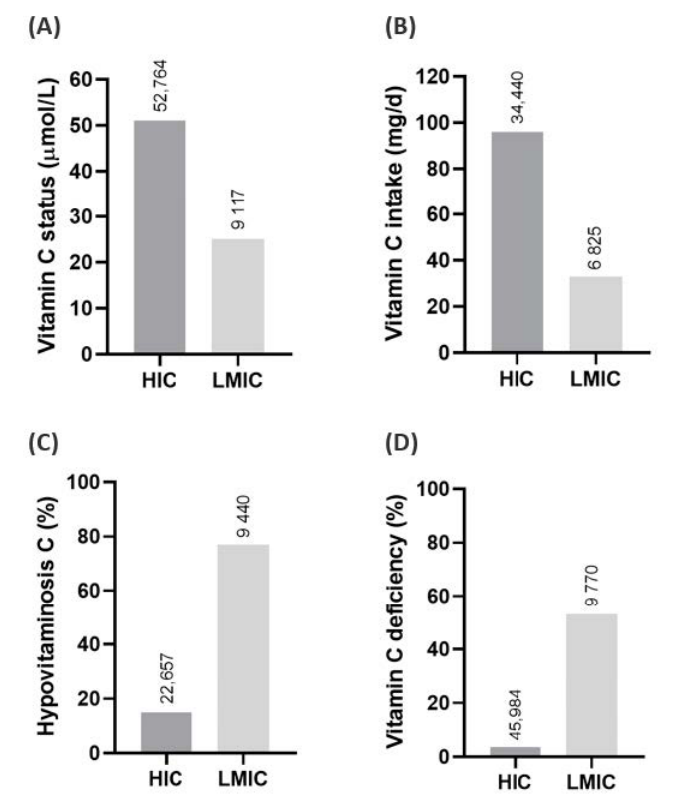
Figure 1. Summary of global vitamin C status ( A ) and intake ( B ) and prevalence of hypovitaminosis ( C ) and vitamin C deficiency ( D ). HIC—high-income countries; LMICs—low-middle-income countries. Hypovitaminosis C, <23 µmol/L; vitamin C deficiency, <11 µmol/L. Numbers above bars indicate the total number of individuals assessed. Data from